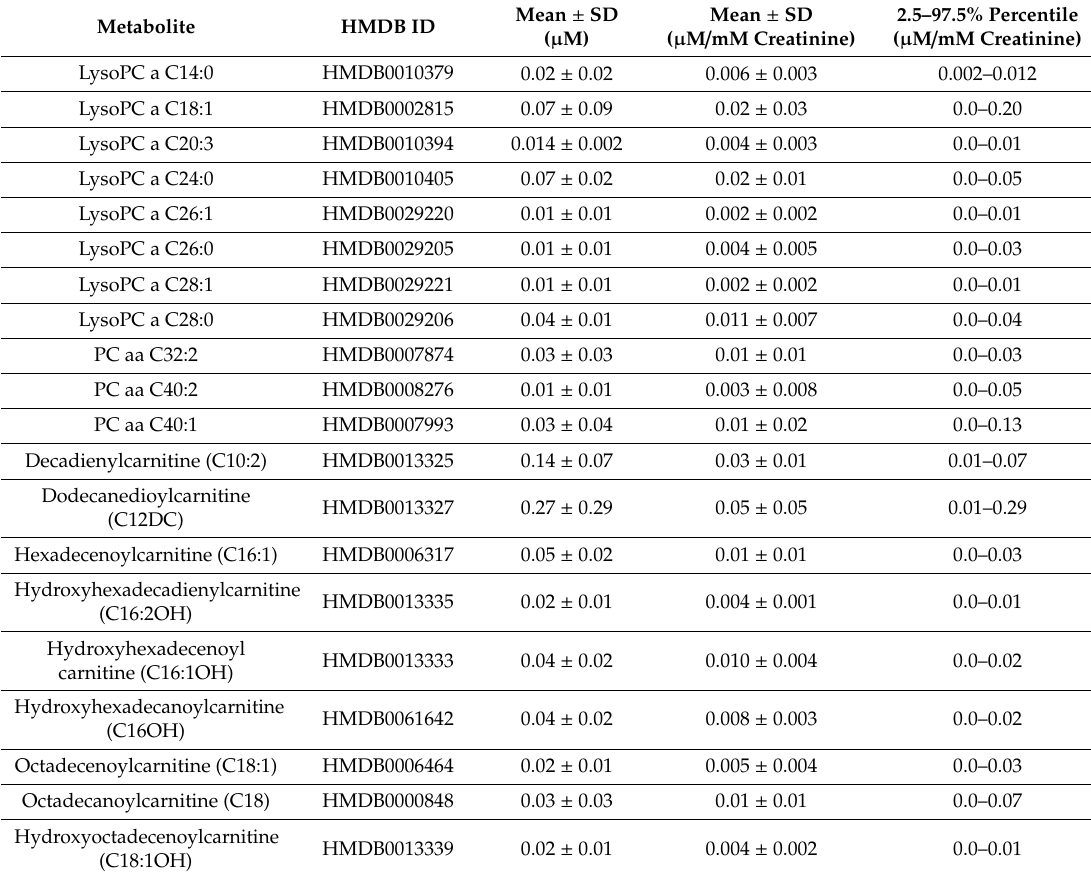
Table 3. Metabolites not previously reported in human